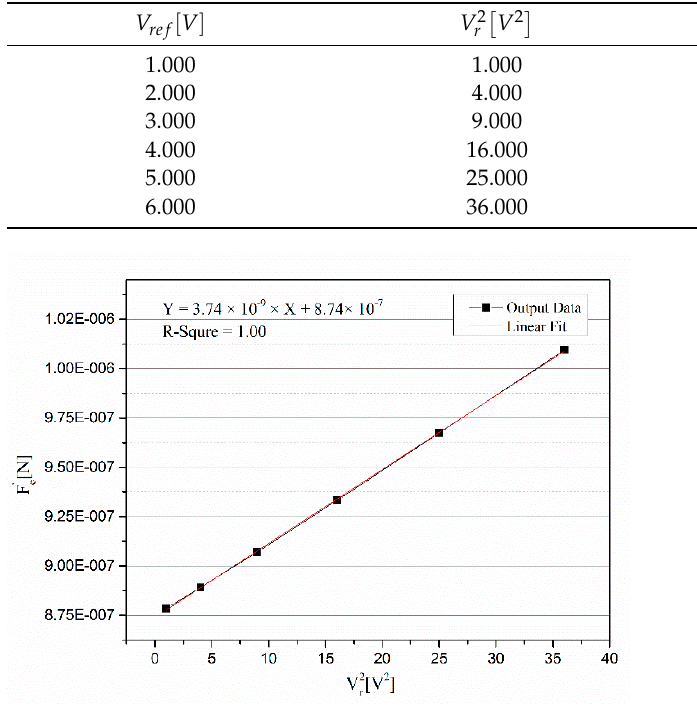
Figure 7. Curve of measuring the mismatch of parasitic capacitance.